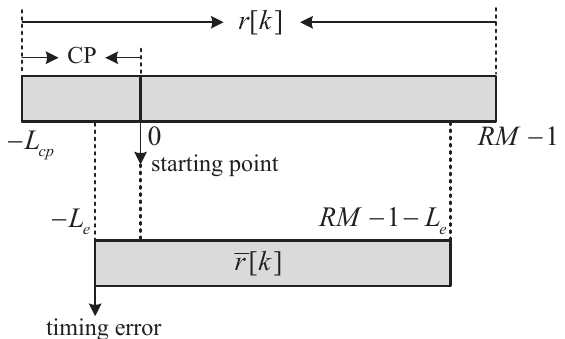
Figure 5. Received signal under a timing